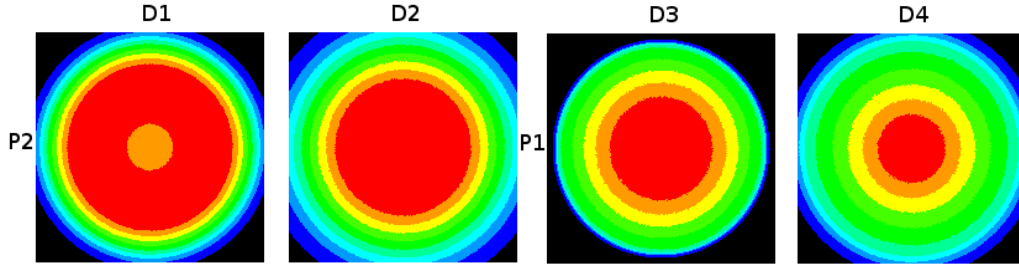
Figure 16. Computer simulations considering non-parallel rays generated according to equations (1) and (2), showing radiation collected at detectors D1, D2 ( before P1 hole ), D3 and D4 ( after P1 hole ). The missing external radiation at detector D3 was blocked by paraboloid P1, when going through the hole. The relative colour scale goes from blue (cold) to red (hot). hole. The relative colour scale goes from blue (cold) to red